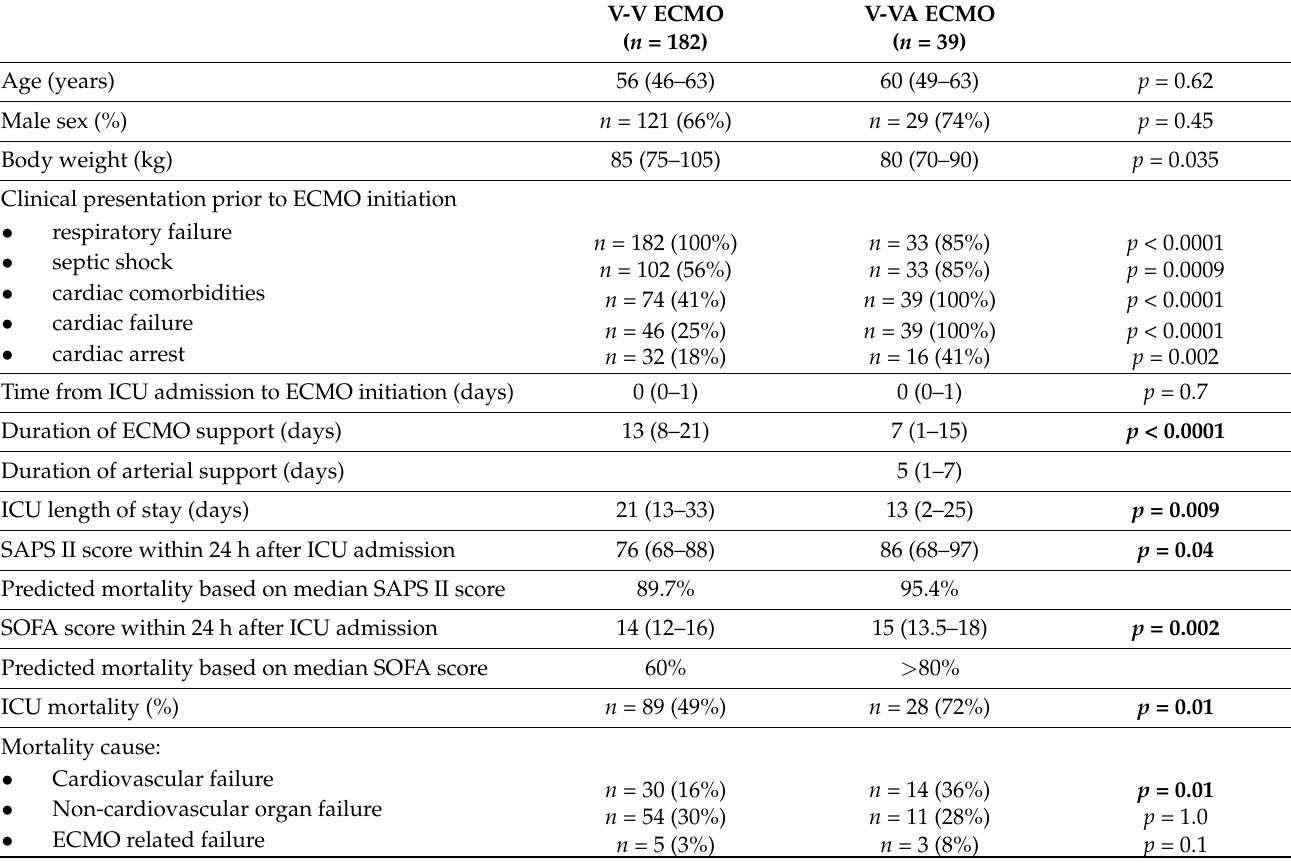
Table 1. Patient demographics and characteristics in V-V and V-VA ECMO